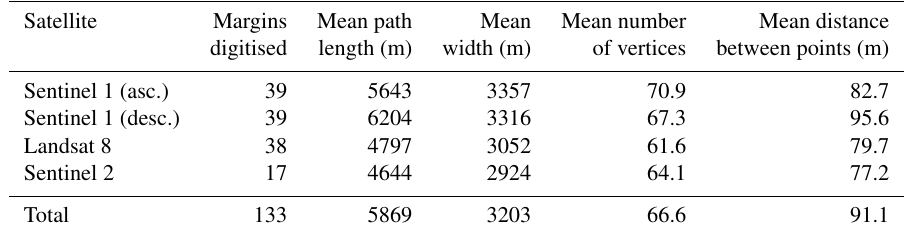
Table 3. Summary statistics for the margins digitised from different